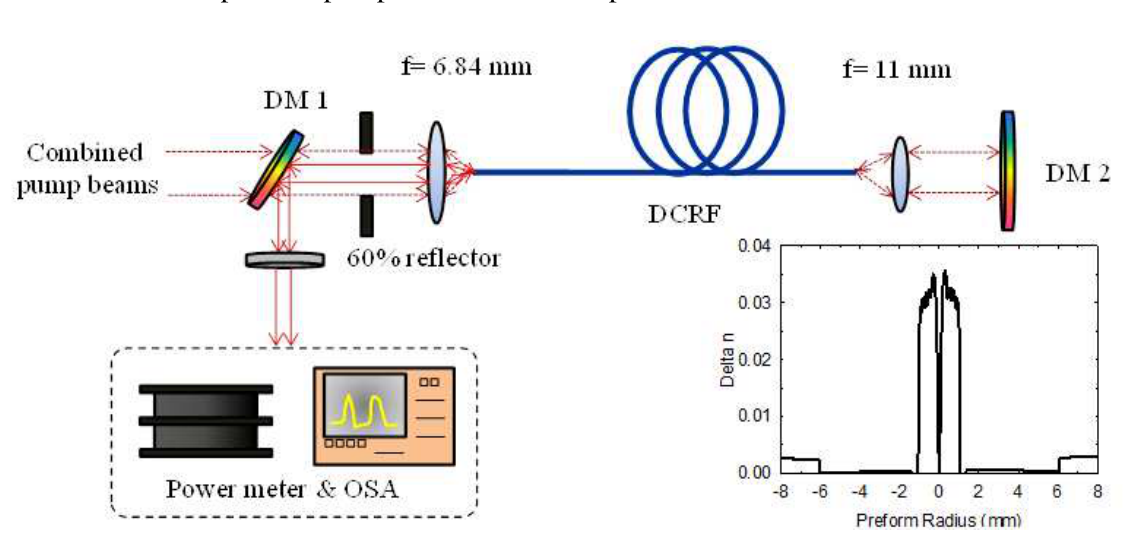
Figure 6. Experimental setup of the CW FRL with DCRF. VBG: volume Bragg grating; DM: dichroic mirror; HR: high reflection mirror; DCRF: double clad Raman gain